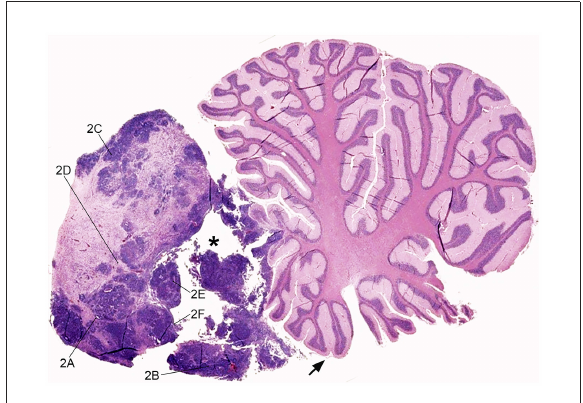
FIGURE1 Feline embryonal tumor located rostrally to the cerebellum, sub-gross view. Sagittal para-medial section of the mass, displacing the rostral cerebellar lobe and occupying the rostral fourth ventricle. The neoplasm infiltrates the rostral medullary velum (arrow), the cerebellar leptomeninges, and focally the cerebellar folia. Densely cellular tumor foci are intermingled with paucicellular eosinophilic areas and focally extensive cystic degeneration (asterisk). The lines indicate the region of acquisition of Figure 2 images. Hematoxylin and eosin (H&E)